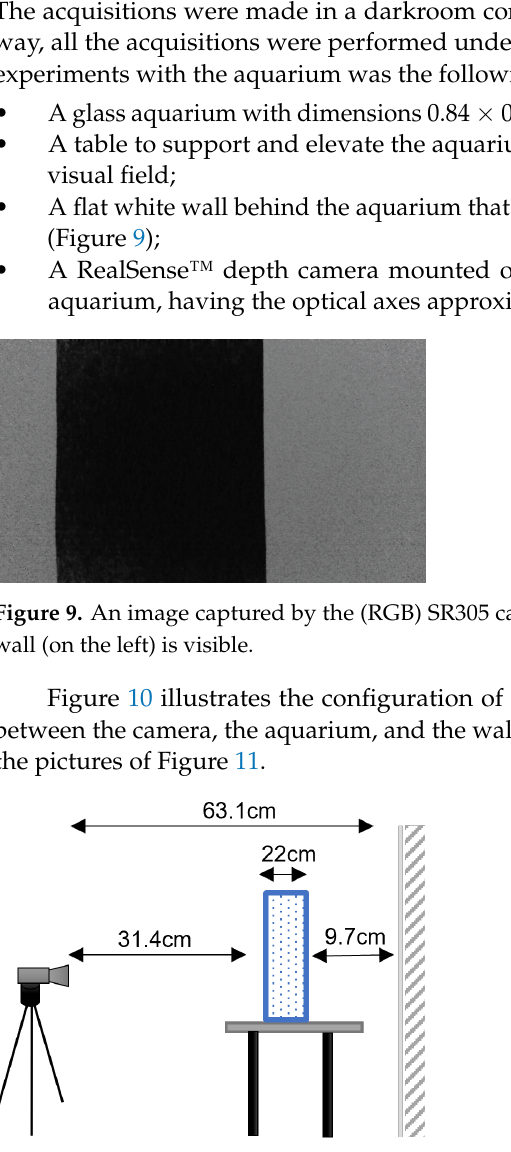
Figure 10. Illustration of the experimental setup. The aquarium is located 9.7 cm away from the wall and the camera is 31.4 cm away from the front surface of the aquarium. Since the width of the aquarium is 22 cm, the distance between the camera and the wall is 63.1